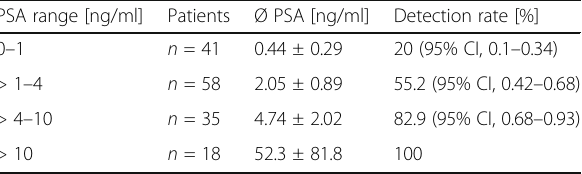
Table 2 Lesion detection by [ 99m Tc]Tc-PSMA-I&S-SPECT/CT